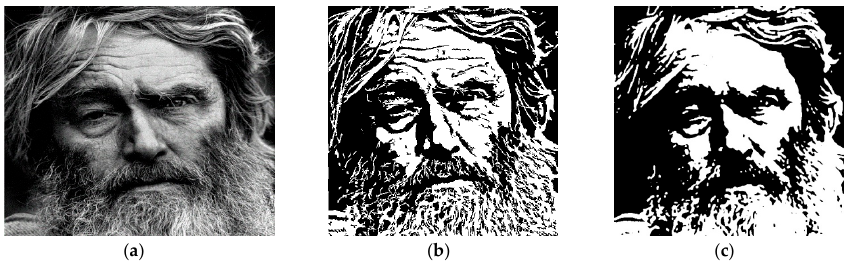
Figure 7. Compared with thresholding method. ( a ) input ( b ) thresholding ( c ) our result.